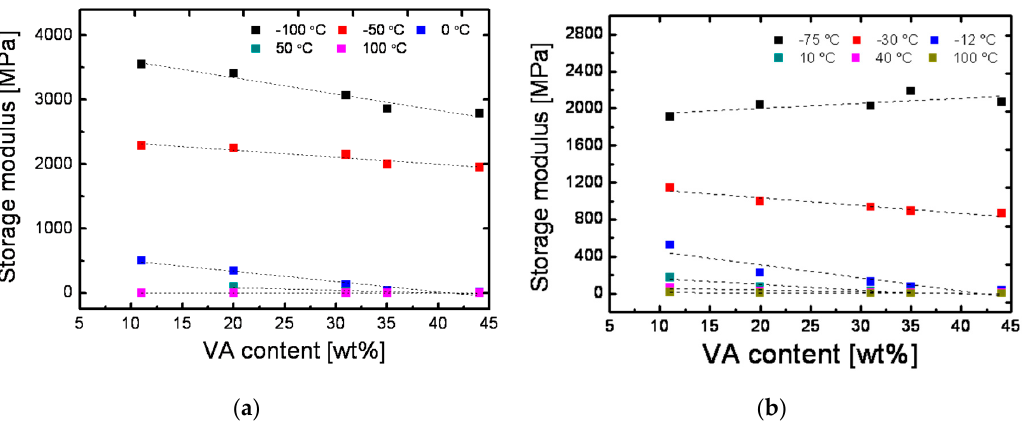
Figure 8. ( a ) Influence of VA-content on the storage modulus of PEVAs at various temperatures: − 100 ◦ C, − 50 ◦ C, 0 ◦ C, 50 ◦ C, and 100 ◦ C. ( b ) Influence of VA-contents on the storage modulus of cPEVAs at various temperatures: − 75 ◦ C, − 30 ◦ C, − 12 ◦ C, 10 ◦ C, 40 ◦ C, and 80 ◦ C.